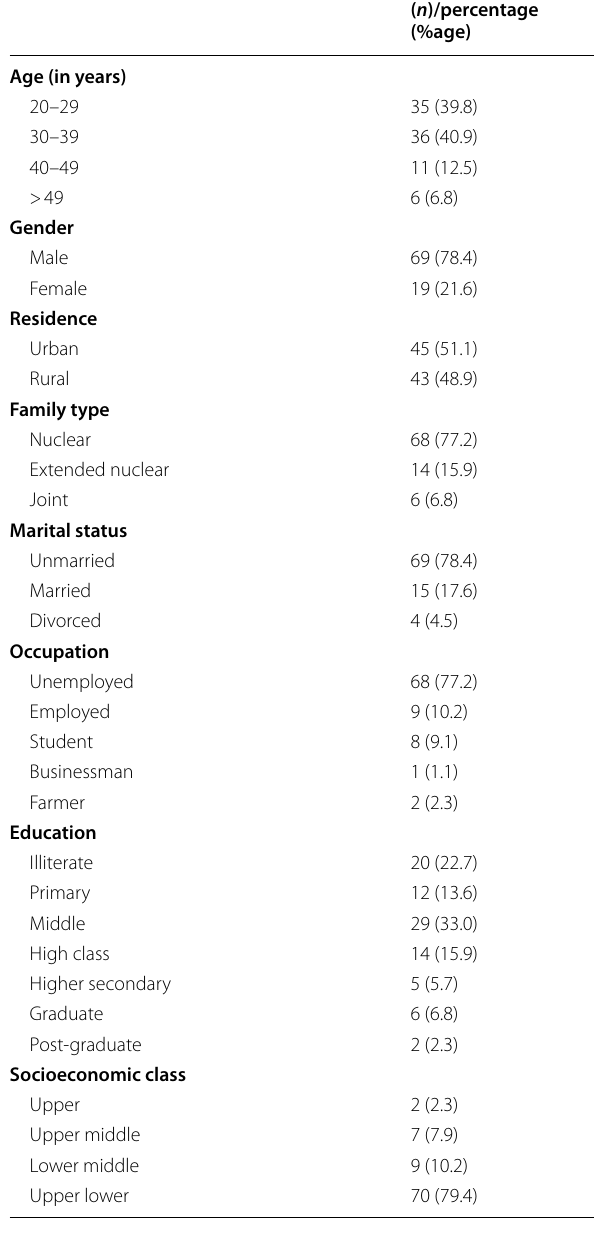
Table 2 clinical profile of patients on clozapine ( n )/percentage